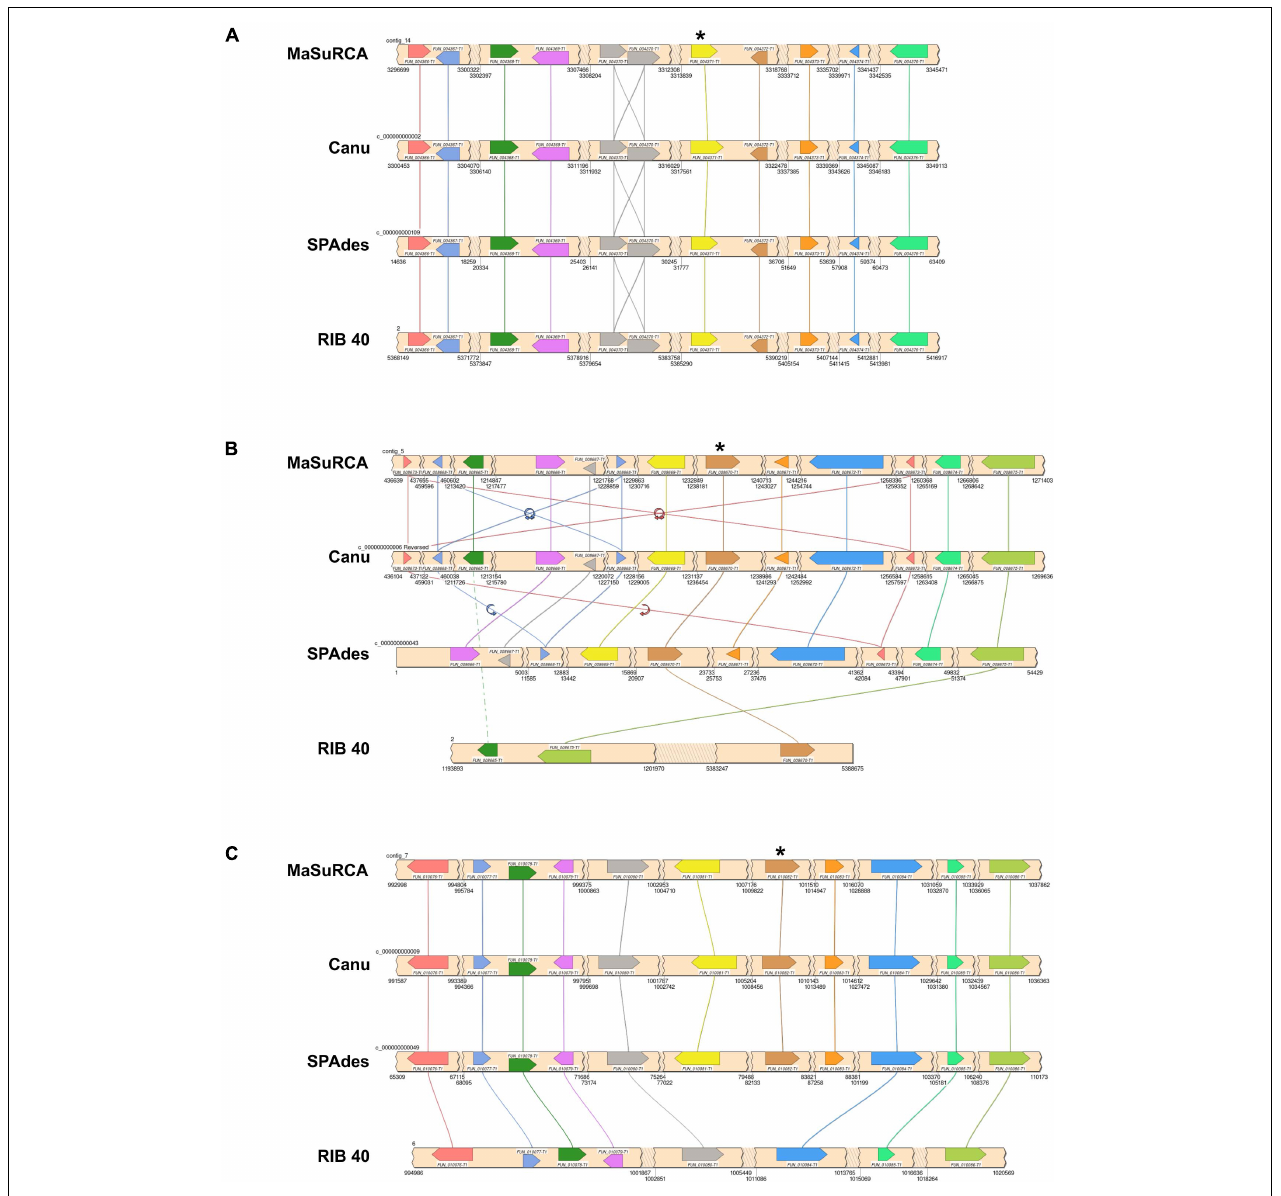
FIGURE 3 | Independent evolution of alpha-amylase duplication in A. oryzae 14160. Synteny analysis of the conserved A. oryzae 14160 alpha-amylase locus on chromosome 2 (A) , the non-syntenic alpha-amylase locus on chromosome 2 (B) , and the non-syntenic alpha-amylase locus on chromosome 6 (C) from three independent genome assemblies of A. oryzae 14160 (MaSuRCA, Canu, and SPAdes) and the reference RIB 40 genome. For each locus, gene direction is indicated by pointed ends, jagged edges indicate a genomic region without protein-coding genes that is skipped for figure clarity. Gene names are with respect to the primary A. oryzae 14160 annotation [generated from the MaSuRCA assembly (Zimin et al., 2013) and annotated with the Funannotate pipeline]. Scaffold ID or chromosome number and coordinates are labeled. “*” represents the alpha-amylase encoding genes. Lines connecting genes indicated conservation, and flip arrows represent a change in gene direction (B) . Locus schematics were generated with SimpleSynteny (Veltri et al.,